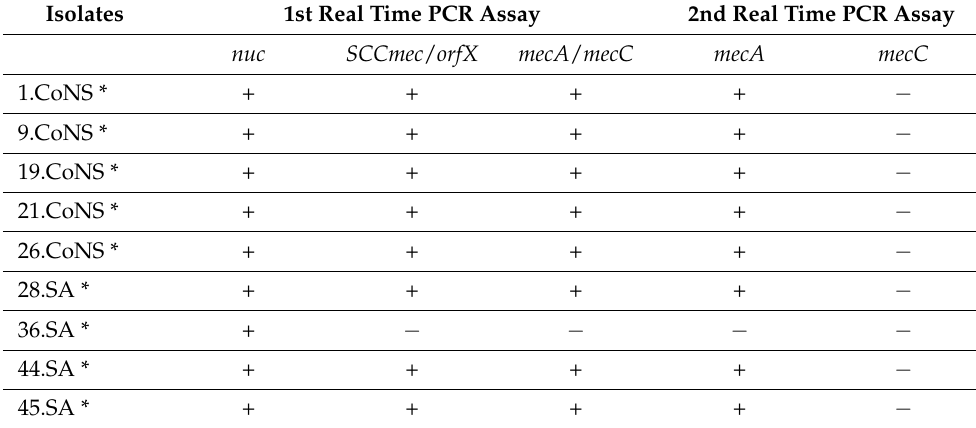
Table 2. Presence of nuc , SCCmec / orfX , mecA and mecC in the tested MRSA and MR-CoNS strains. Isolates 1st Real Time PCR Assay 2nd Real Time PCR Assay nuc SCCmec / orfX mecA / mecC